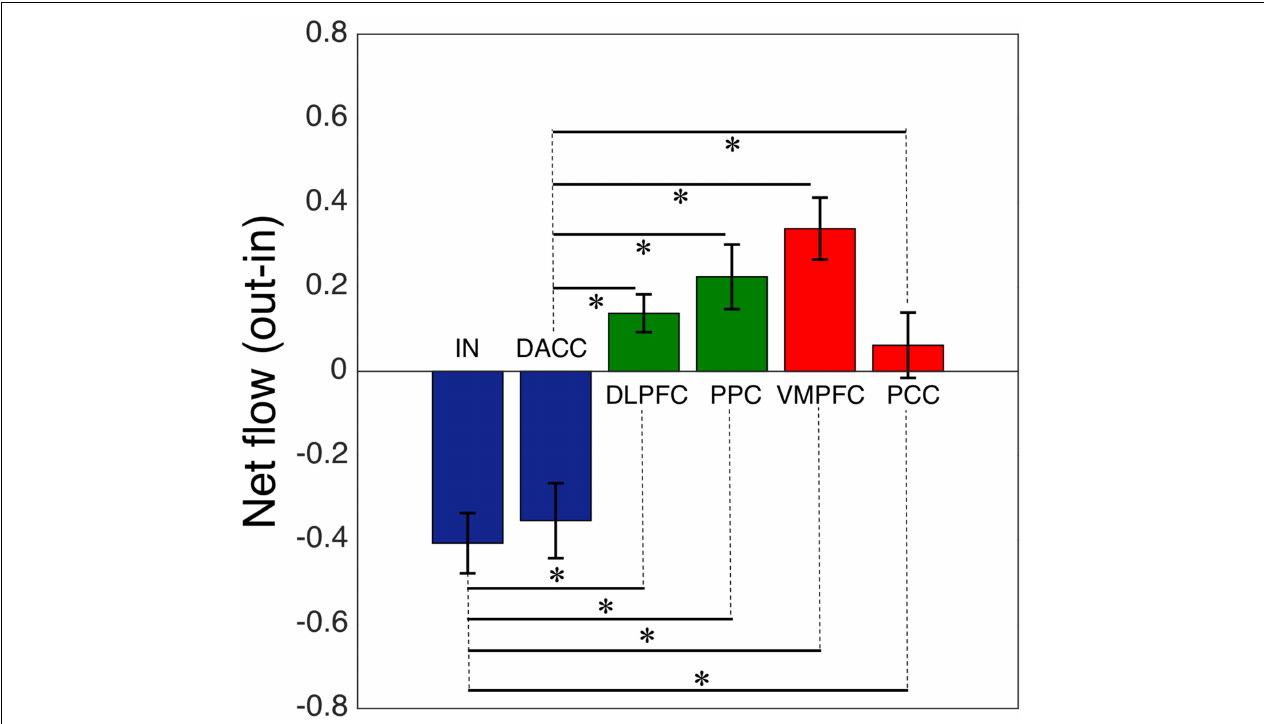
FIGURE 2 | Net flow (information outflow minus information inflow) of the key nodes of the salience (IN, insula; DACC, dorsal anterior cingulate cortex), central-executive (DLPFC, dorsolateral prefrontal cortex; PPC, posterior parietal cortex) and default-mode (VMPFC, ventromedial prefrontal cortex; PPC, posterior cingulate cortex) networks. The AI and DACC of the salience network had a significantly lower net information flow compared with the central-executive and default-mode nodes ( ∗ indicates statistical significance).